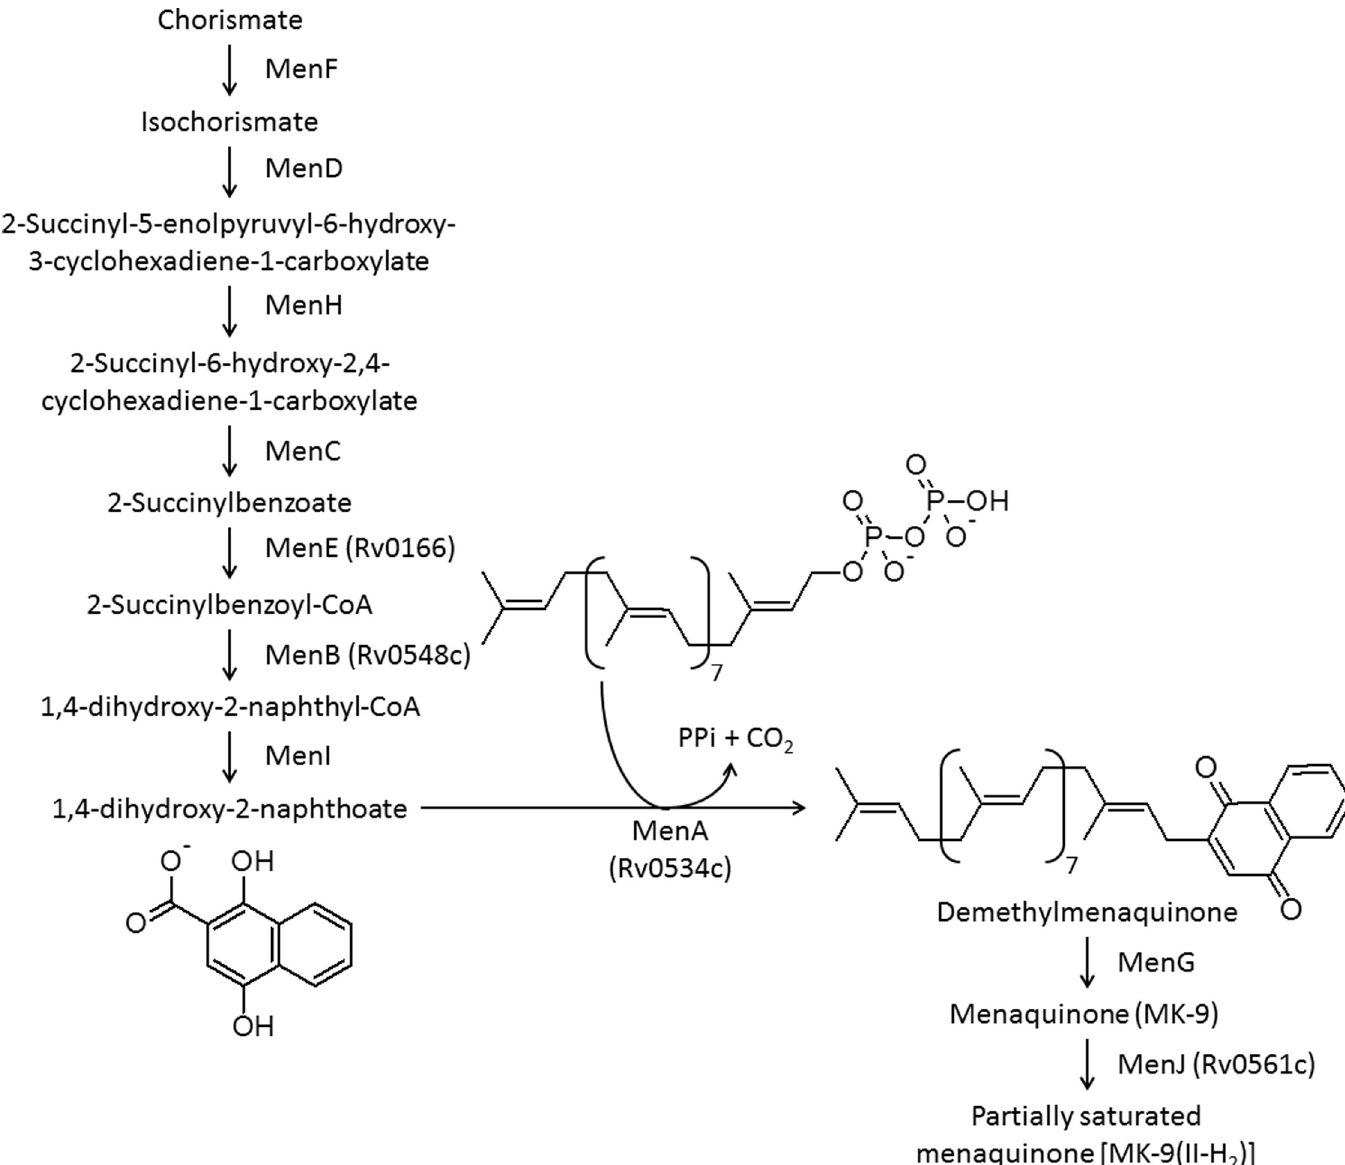
Fig 1. Biosynthetic pathway for menaquinone in mycobacteria. The reaction catalyzed by MenA is shown. Rv numbers have been provided for enzymes for which the activity has been empirically demonstrated.